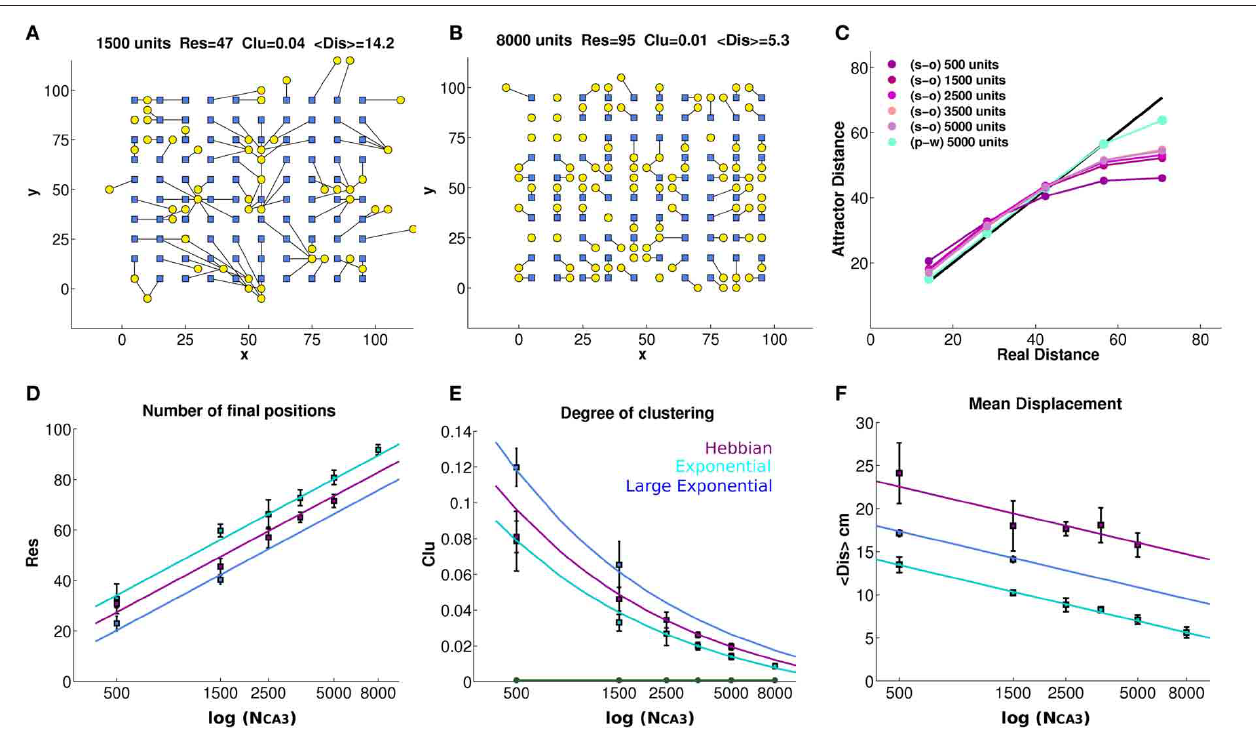
FIGURE 2 | Finite size effects eventually vanish, but the tendency to drift persists. The bump tends to drift from any initial position in the environment, encoded in the inputs, to the final position decoded from the complete CA3 activity vector in the self-sustaining attractor ( A and B ), even when noise is very low ( δ = 0 . 002). Each initial position (blue square) is connected to its final position (yellow circle) through a black line, showing strong drift of the bump as a result of turning off DG inputs, in a network of 1500 units with connectivity self-organized through Hebbian learning (A) , and much weaker drift in a network of 8000 units with pre-wired exponential connectivity and spread λ = 1 (B) . The panels (A) and (B) reports the number of distinct final positions Res , the degree of clustering Clu and the mean displacement from initial to final position < Dis > , whose average values over simulations with different network sizes are reported in the bottom row. (C) The average distance between final positions corresponding to a given input distance along the diagonal of the torus. As the network gets larger the global metric distortion of a self-organized net is reduced, approaching the black (identity) line, but very slowly. In contrast, a pre-wired network is much less distorted (light blue).